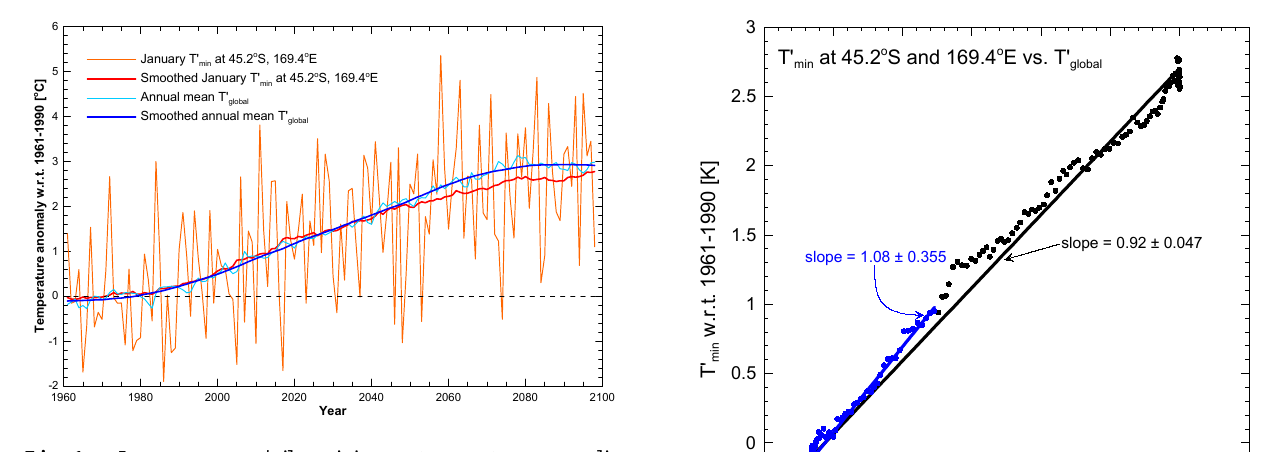
Fig. 1. January mean daily minimum temperature anomalies (with respect to 1961-1990) at 45.2 ◦ S, 169.4 ◦ E extracted from a HadGEM2-ES simulation under RCP 4.5 emissions (orange), the time series smoothed using the Savitzky-Golay filter (red), the annual mean global mean surface temperature anomaly (with respect to 1961-1990) time series ( T 0 global ) from the same model simulation and emission scenario (pale blue) and the smoothed T 0 global time series (blue). Fig. 2. Smoothed January mean daily minimum temperature anomalies at 45.2 ◦ S, 169.4 ◦ E regressed against annual mean global mean surface temperature anomalies. The data shown are from a single simulation, with the blue dots showing data from 1961 to 2012 and the black dots showing data from 2013 to 2100. All anomalies are with respect to the 1961-1990 baseline. Regression model fits (solid lines) are shown for 1961-2012 to indicate how a fit might look were it based on observations (blue solid line) alone and 1961-2100 to indicate the result obtained using a much longer time series (black solid line).